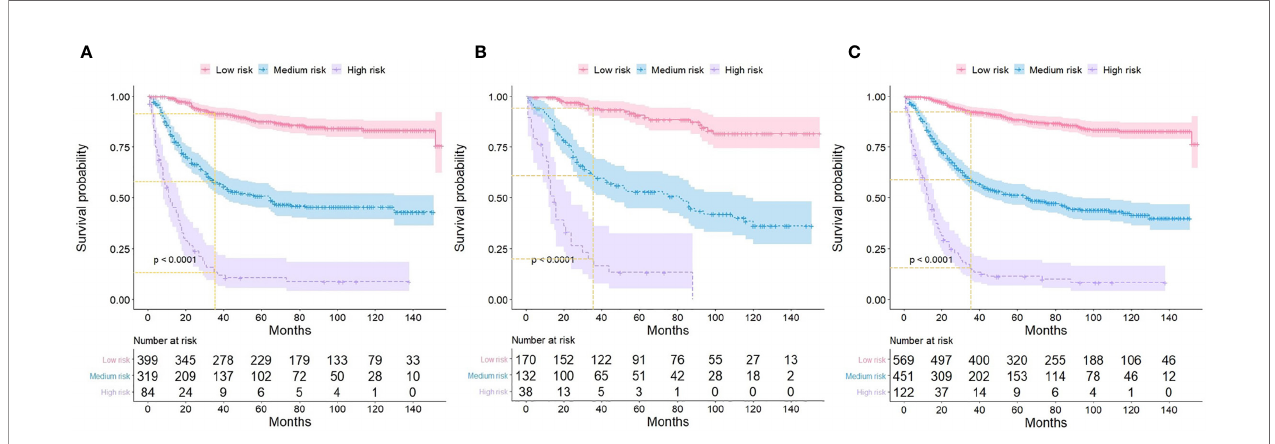
FIGURE 5 | Kaplan-Meier curves showing the cancer-speci fi c survival of ASCC patients with different risk groups in training (A) , validation (B) , and the total cohort (C)